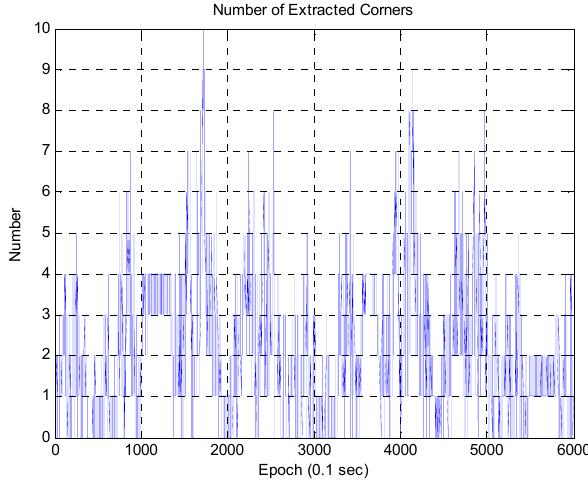
Figure 21. Number of extracted corners.